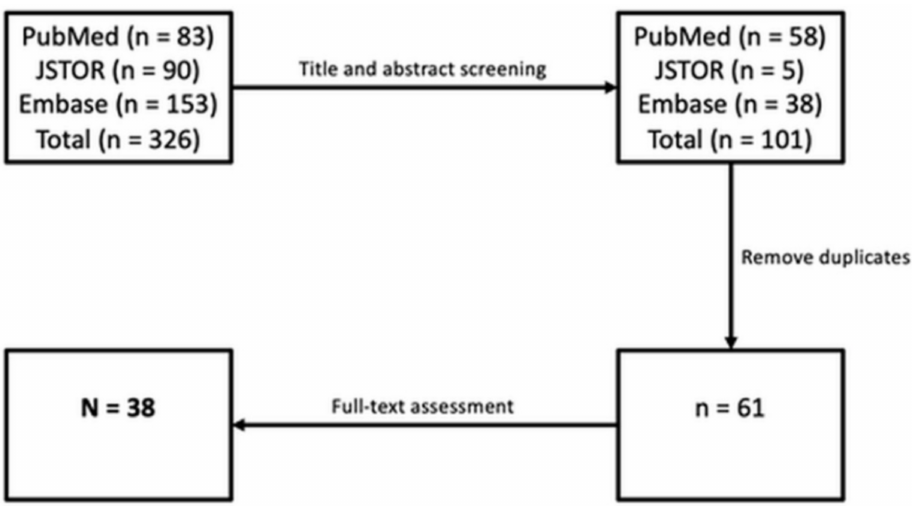
Figure 1. Flow diagram describing the literature search strategy